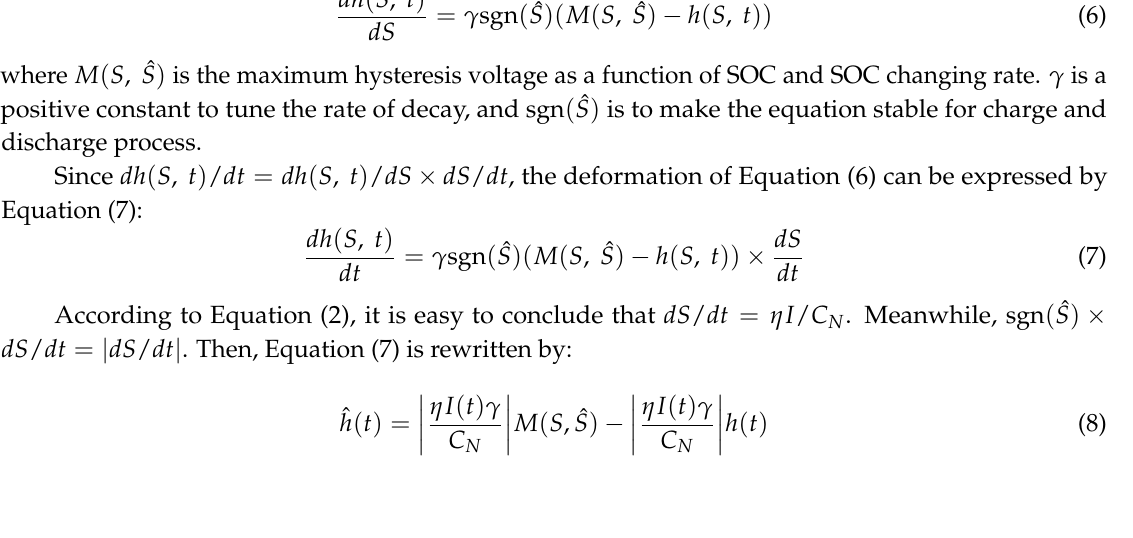
Figure 2. Open circuit voltage (OCV) discharge and charge boundary at 30 °C: ( a ) the discharge and charge curve; ( b ) the hysteresis level.